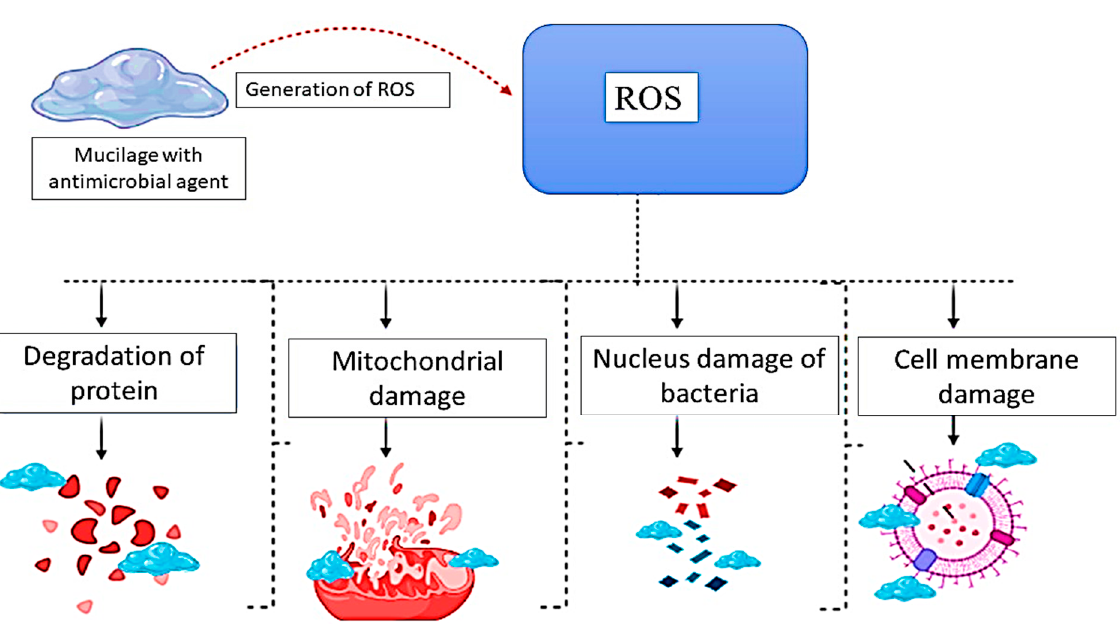
Figure 3. Possible mechanism of antimicrobial efficacy of plant-based mucilage. The mucilage is helpful in the development of free radicals by the membrane, which leads to porosity and the death of the cell. Moreover, mucilage generates ROS (reactive oxygen species), which are free radicals that easily react with other molecules in the cell due to the presence of oxygen, which causes the damaging of proteins, RNA, and DNA [91]. Oxidative stress of ROS is a major cause of damage to the cell membrane due to lipid peroxidation. The mucilage can attach to the bacterial cell wall through several interactions in the cell membrane; therefore, the reducing the viability of the bacterial cell by inhibiting DNA replication. The bacterial cell comprises DNA bases enriched in sulfur and phosphorus, these biomaterials associate with the mucilage. Moreover, mucilage can break down the cell membrane permeability of pathogenic bacteria such as E. coli , S